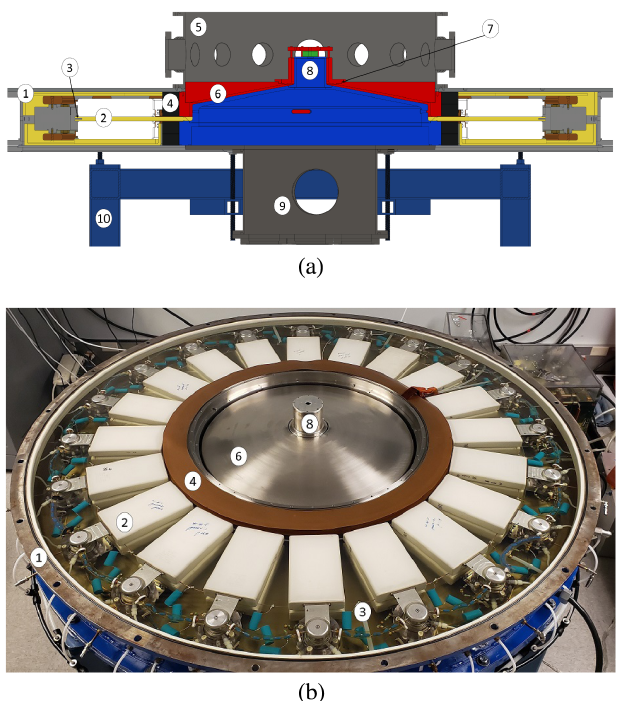
FIG. 1. (a) Cross-section CAD drawing of the LTD machine, with highlighted relevant components. 1 ¼ LTD cavity, 2 ¼ LTD bricks, 3 ¼ trigger line, 4 ¼ ferromagnetic cores, 5 ¼ vacuum chamber, 6 ¼ vacuum power feed, 7 ¼ location of B-dot probes, 8 ¼ load region, 9 ¼ vacuum pumps spool, and 10 ¼ support frame. (b) Photo of the LTD cavity without the vacuum chamber, power feed anode, and cavity